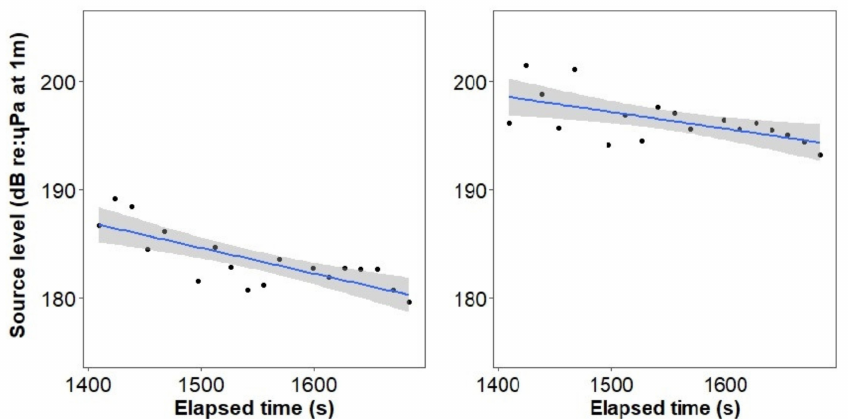
Figure 6. Estimated source levels from 20 Hz fin whale notes manually detected in the H-channel ( left ) and the Z-channel ( right ) from the OBS off southwest Portugal against elapsed time within a sequence longer than 1400 s. A linear regression line (blue) is fitted to the data with its associated 95% confidence intervals (shaded grey). Black dots represent estimated source